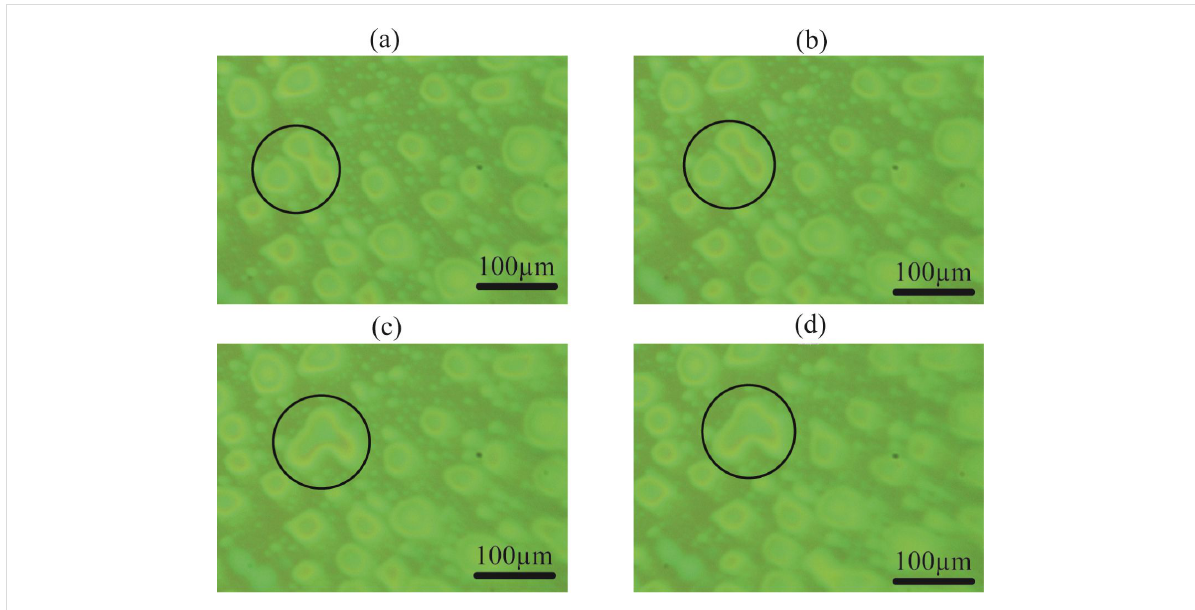
Figure 4: Optical images of the coalescence of spherical domains formed on PS-coated surfaces. (a–d) Time lapse images where the encircled area shows the coalescence of an irregular domain with an approximately spherical domain in the vicinity. Additional examples of coalescence are given in Supporting Information File 1, Figure S2 and Figure